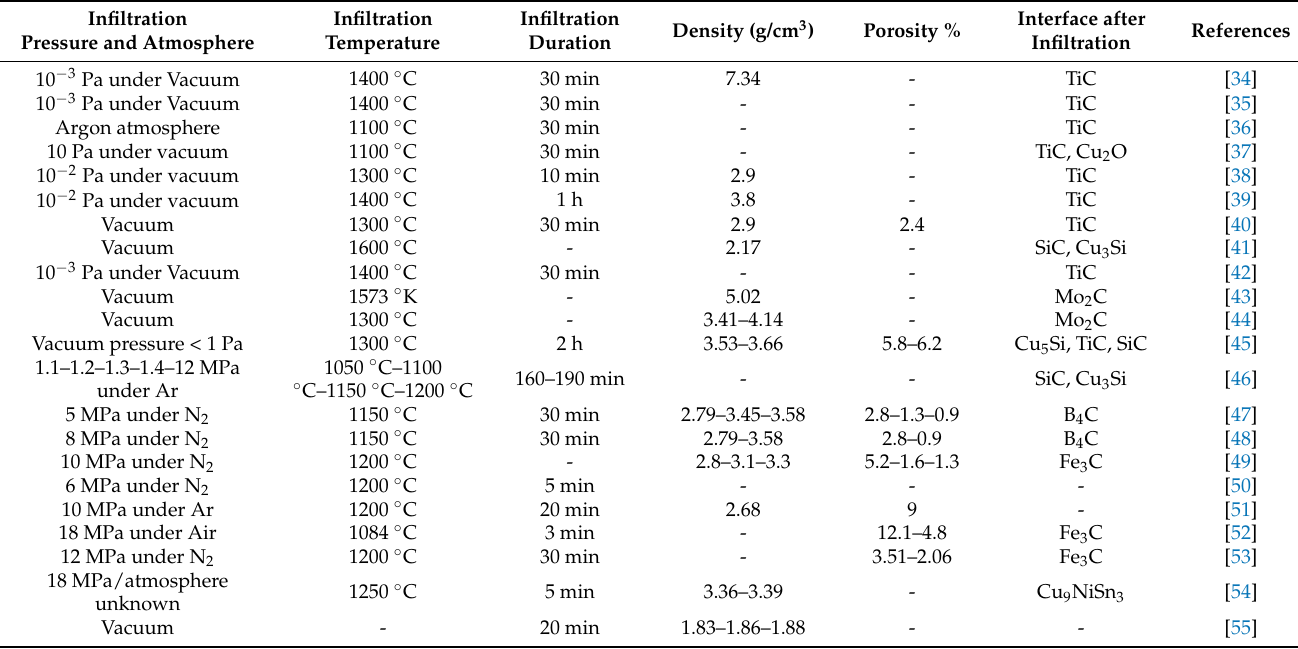
Table 2. Infiltration properties of materials in the